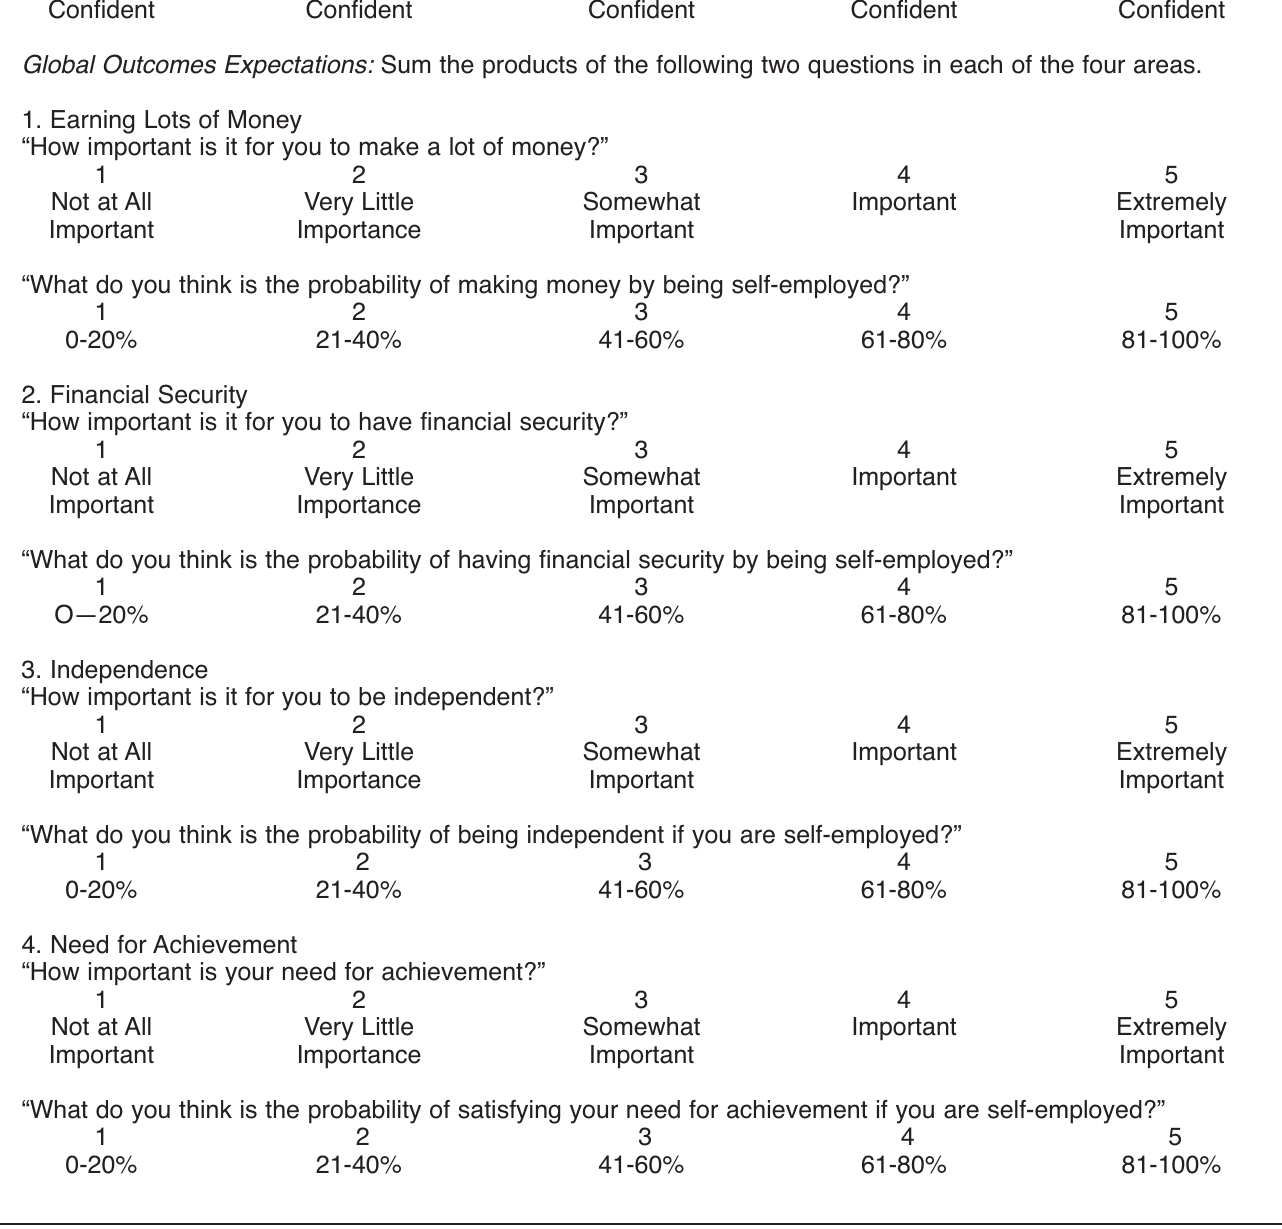
Figure 2. Survey instrument